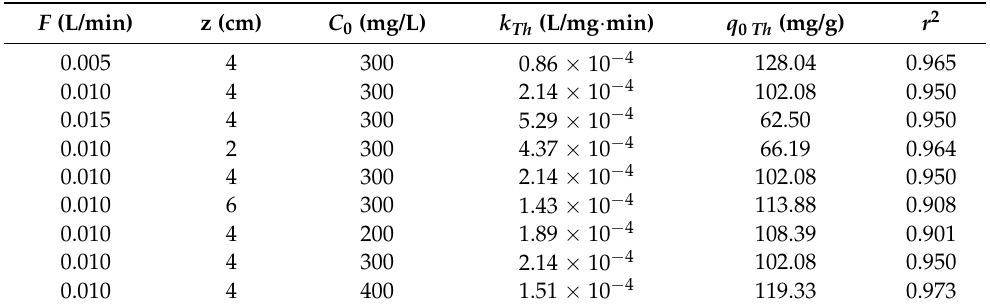
Table 4. Adsorption data from the Thomas model of the column adsorption of MB onto functionalized